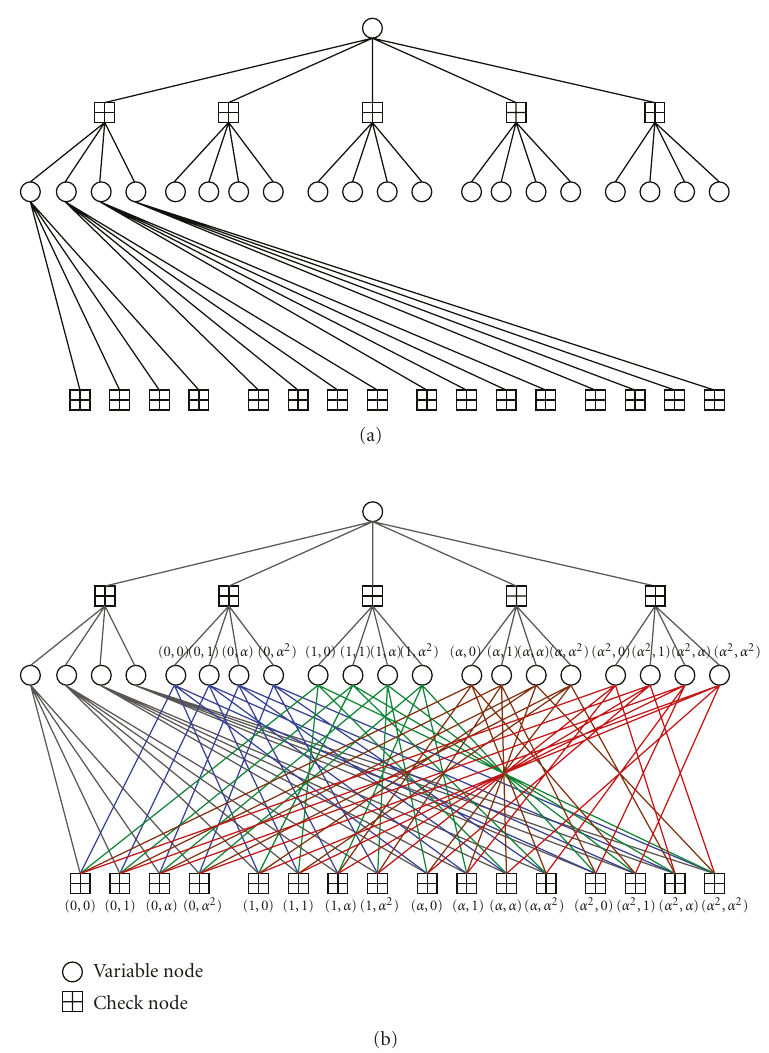
Figure 2: Tree constructed for a = 2, s = 2 after (a) steps (1)–(3), and (b) step (4) (the final